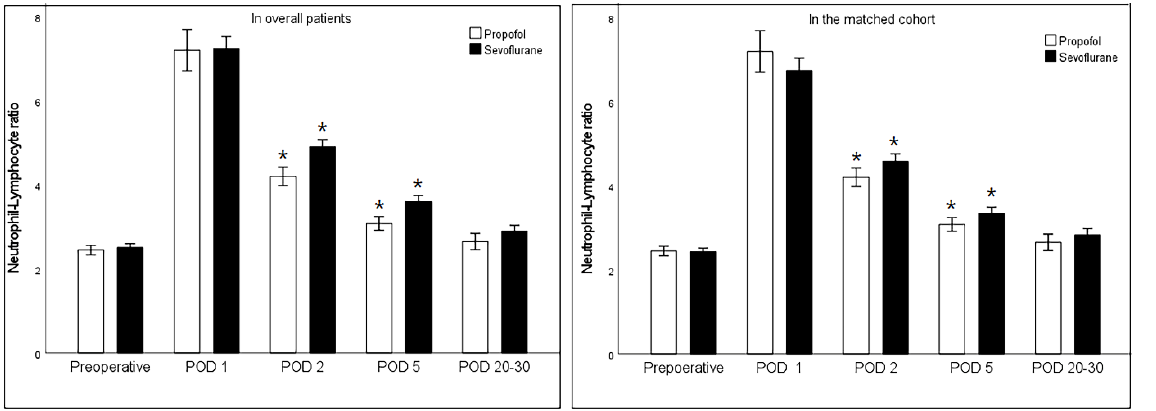
Figure 2. Change of neutrophil-lymphocyte ratio in the perioperative period. POD; postoperative day. * means p < 0.05 when compared with logistic regression using generalized estimating equations with Bonferroni correction in a propensity score matched cohort.